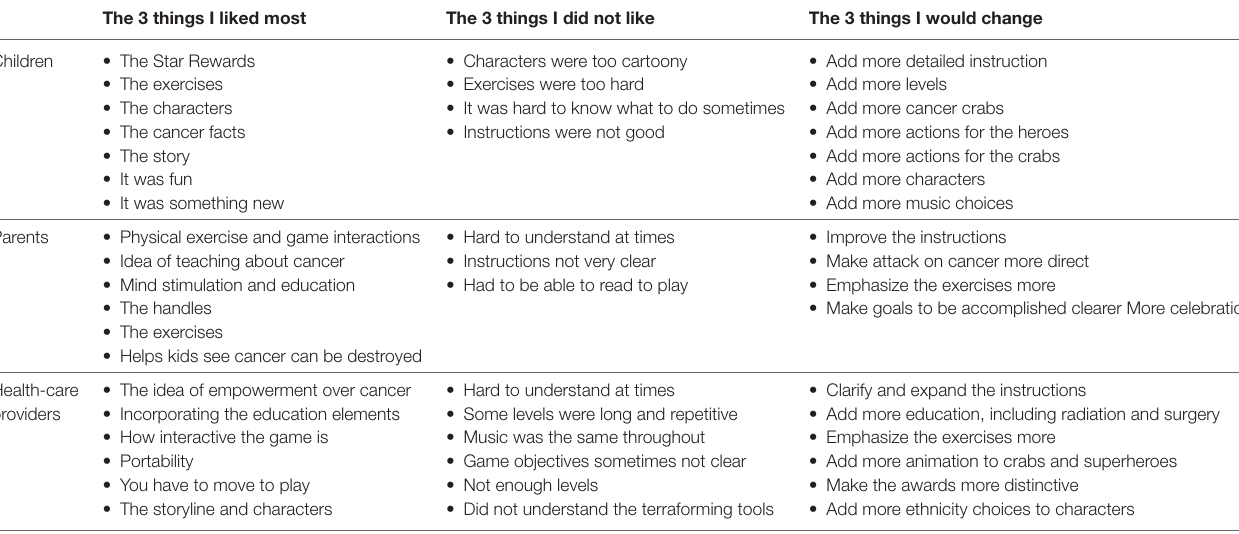
TaBle 1 | Ten children, 10 parents, and 12 health-care providers completed “The 3 things … ” simple sentence completion tool after playing or observing their child play Empower Stars